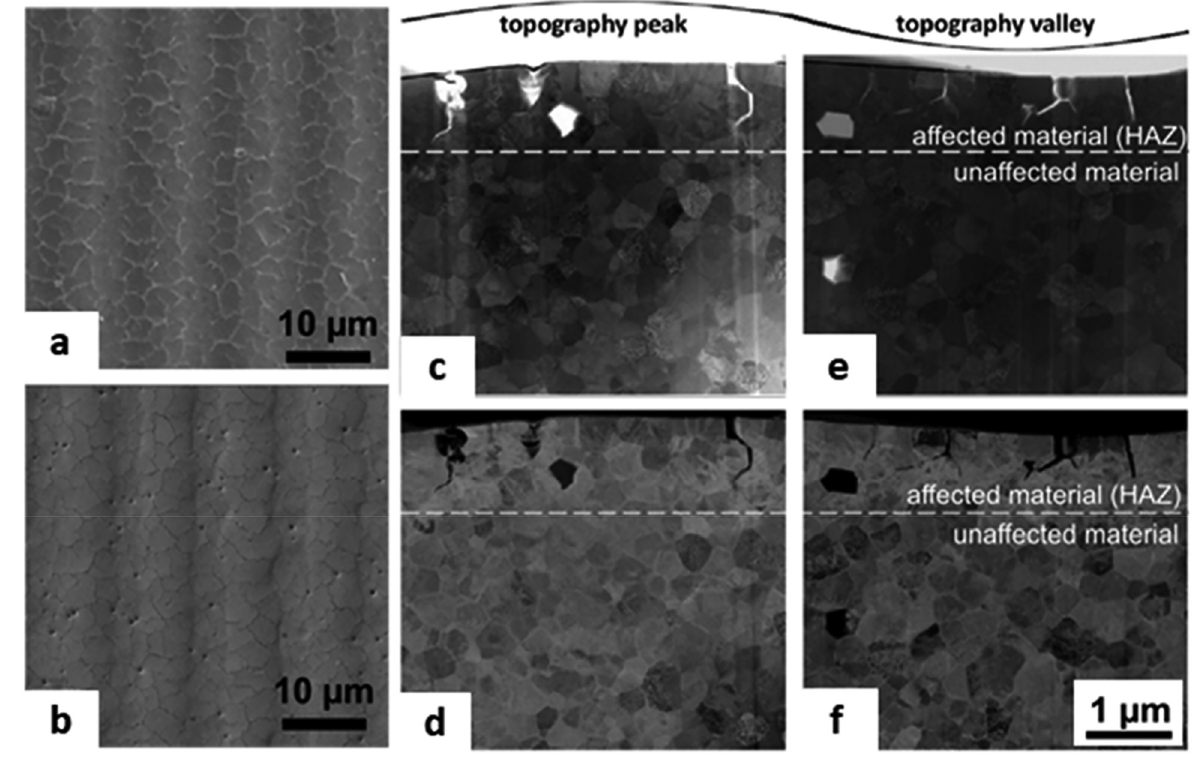
Figure 13: Comparison of DLIP processing on zirconia with two different wavelengths: (a) 532 nm and (b) 355 nm. STEM images of FIB-cut lamellaacrossaridgepeak(c)and(d)andvalley(e)and(f).Bright fi eldimagesareshownin(c)and(d),whereasdark fi eldimagesin(d)and(f). Figures adapted from ref. [128] (© 2017 Elsevier